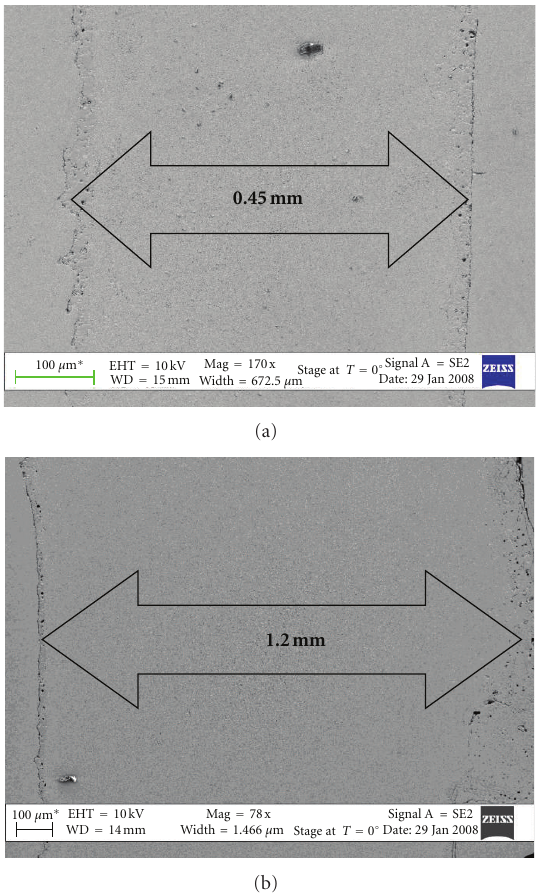
Figure 16: Composite of di ff erent thicknesses, (a) 0.45 mm, and (b) 1.2 mm.